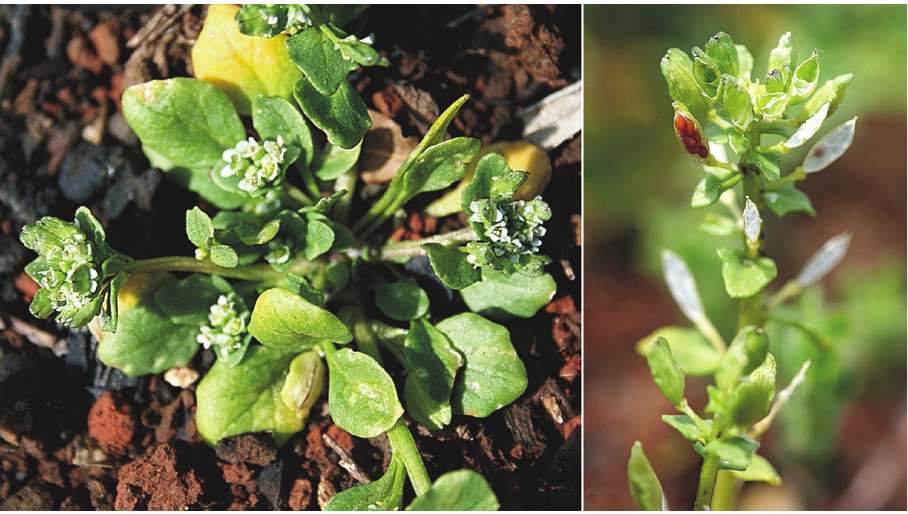
Figure 3. Ionopsidium albiflorum photographed in Santeramo in Colle (Bari). Picture by E.V. Perrino and G.N.